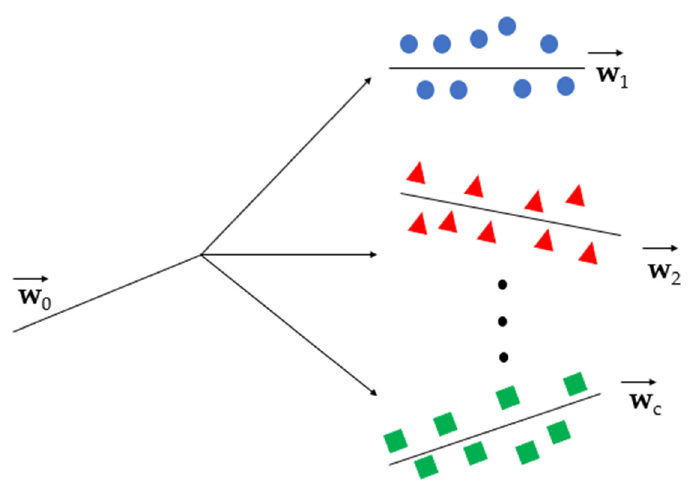
Figure 7. Illustration of the underlying multiinput multioutput scheme